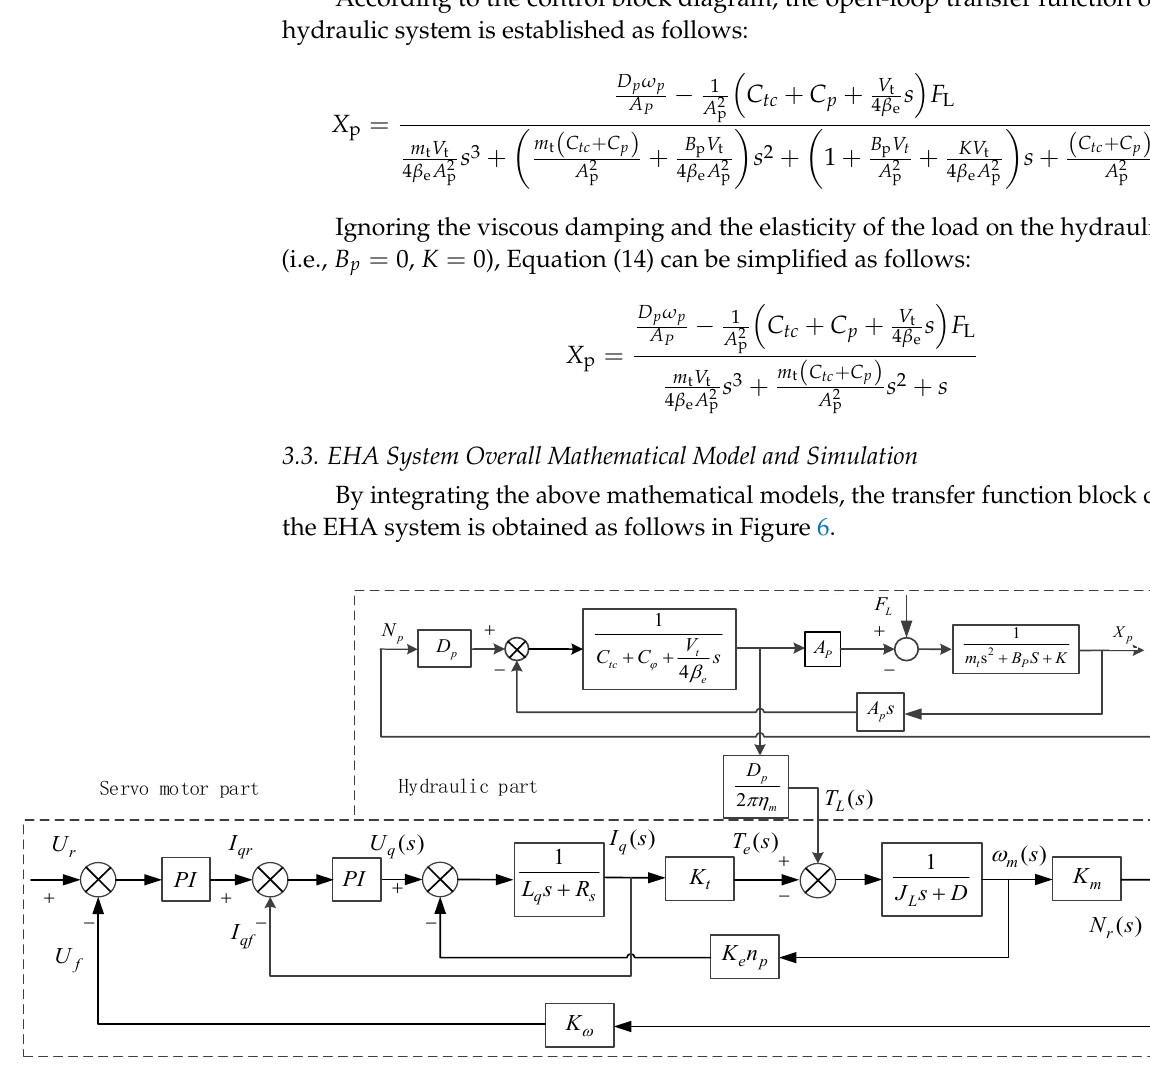
Figure 6. EHA system transfer function block diagram.